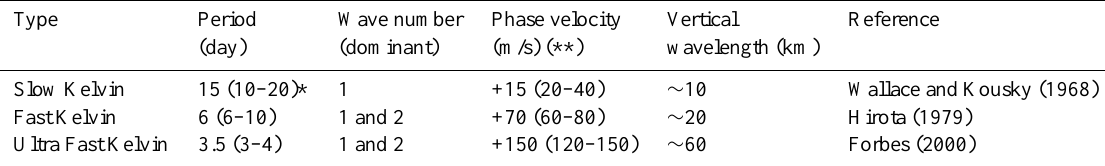
Table 1. Characteristics of Equatorial Kelvin waves from literature. Type Period Wave number Phase velocity Vertical Reference Slow Kelvin Wallace and Kousky (1968) Fast